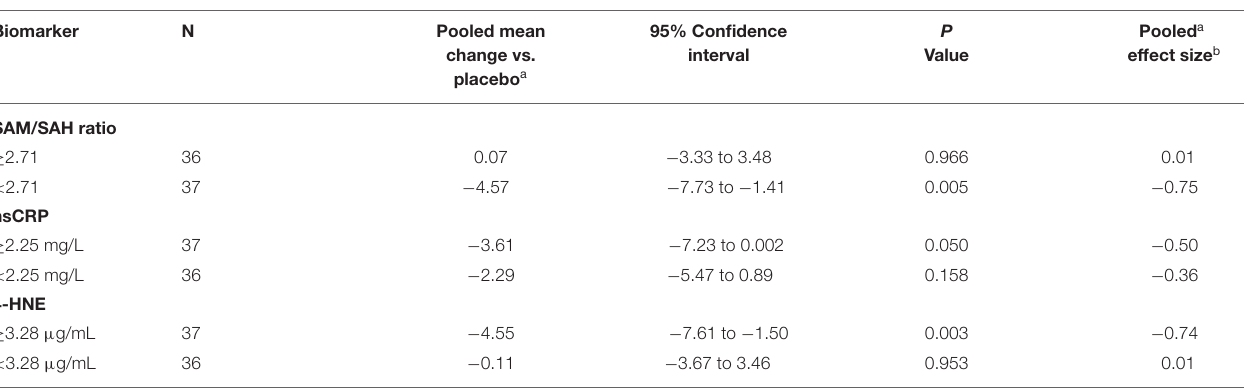
TABLE 1 | Pooled effect size of L-Methylfolate by levels of biomarkers